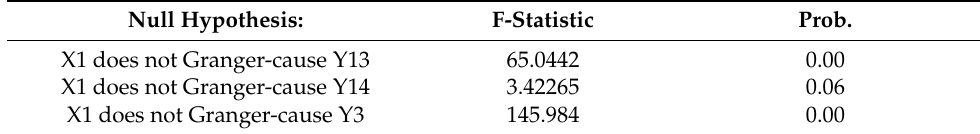
Table 1. Pairwise Granger causality test results (lags: 2). Null Hypothesis: F-Statistic Prob. X1 does not Granger-cause Y13 65.0442 0.00 X1 does not Granger-cause